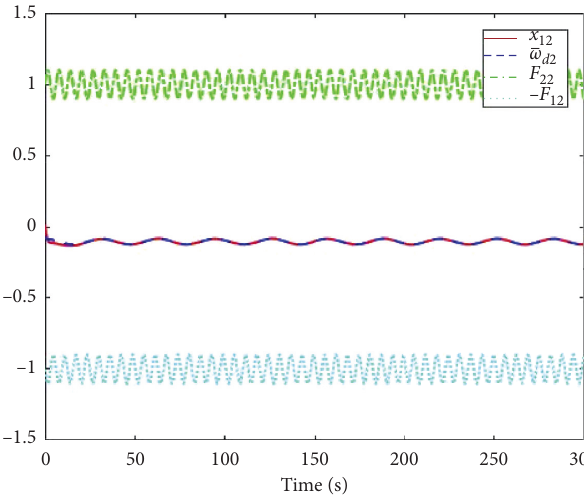
Figure 2: Trajectory of ϖ